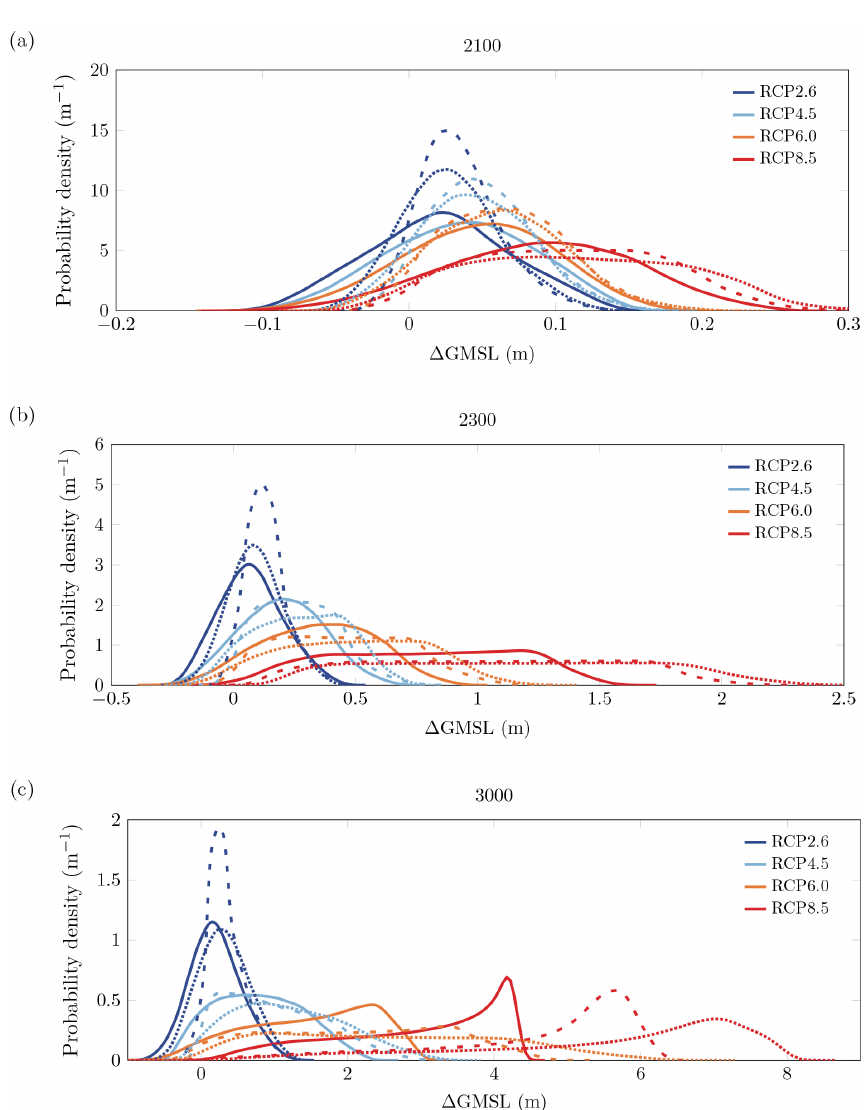
Figure 7. Probability density functions for the AIS contribution to sea level at (a) 2100, (b) 2300 and (c) 3000 under the viscous sliding law (solid lines), the weakly non-linear sliding law (dashed lines) and the strongly non-linear sliding law (dotted lines).